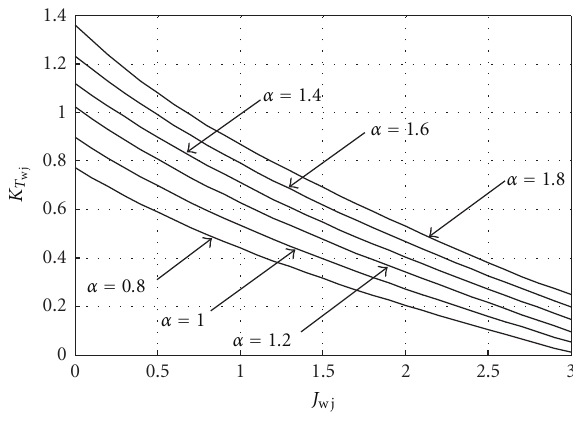
Figure 11: Jet thrust coe ffi cients.